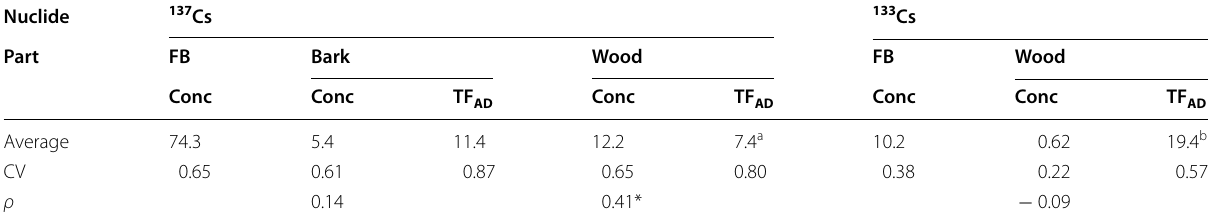
Table 1 Relationships between the cap Cs concentration and bed log Cs concentration and toCs TF cultivation